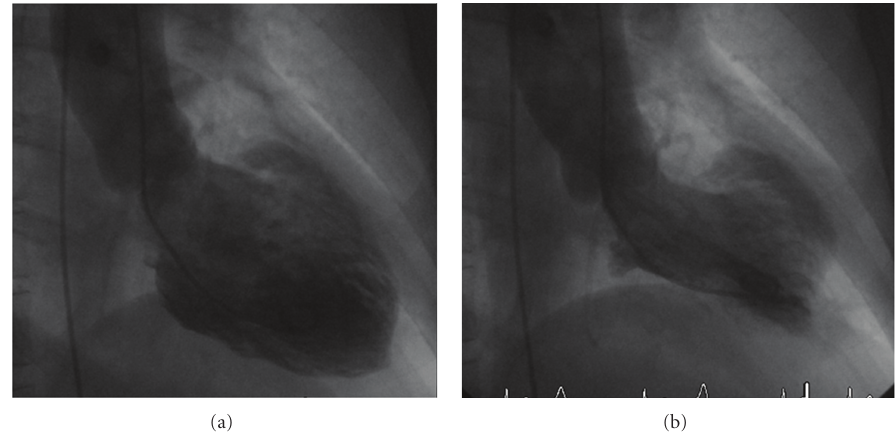
Figure 1: Left ventricular angiogram on admission revealing anterolateral ballooning.